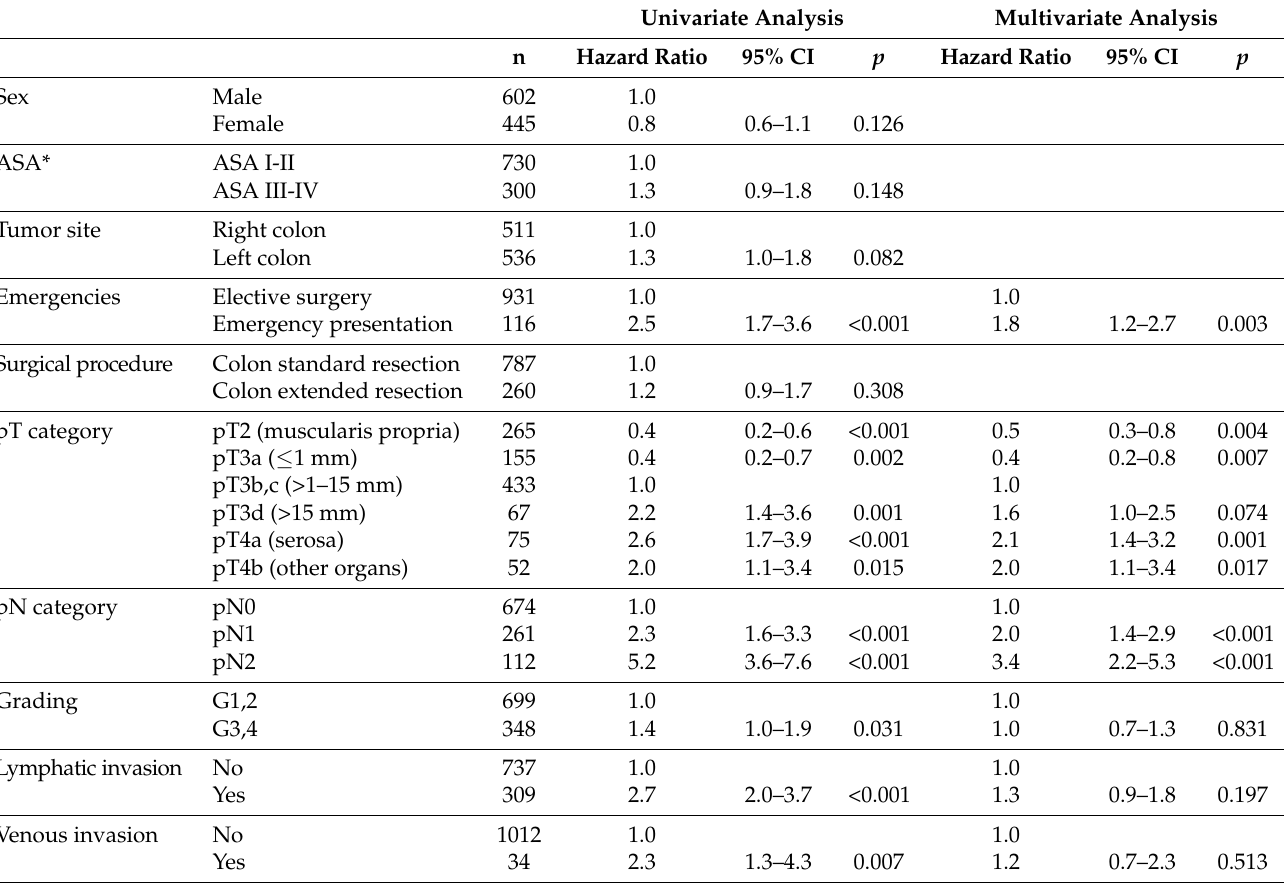
Table 5. Distant metastases, multivariate Cox regression analysis (n = 1047).